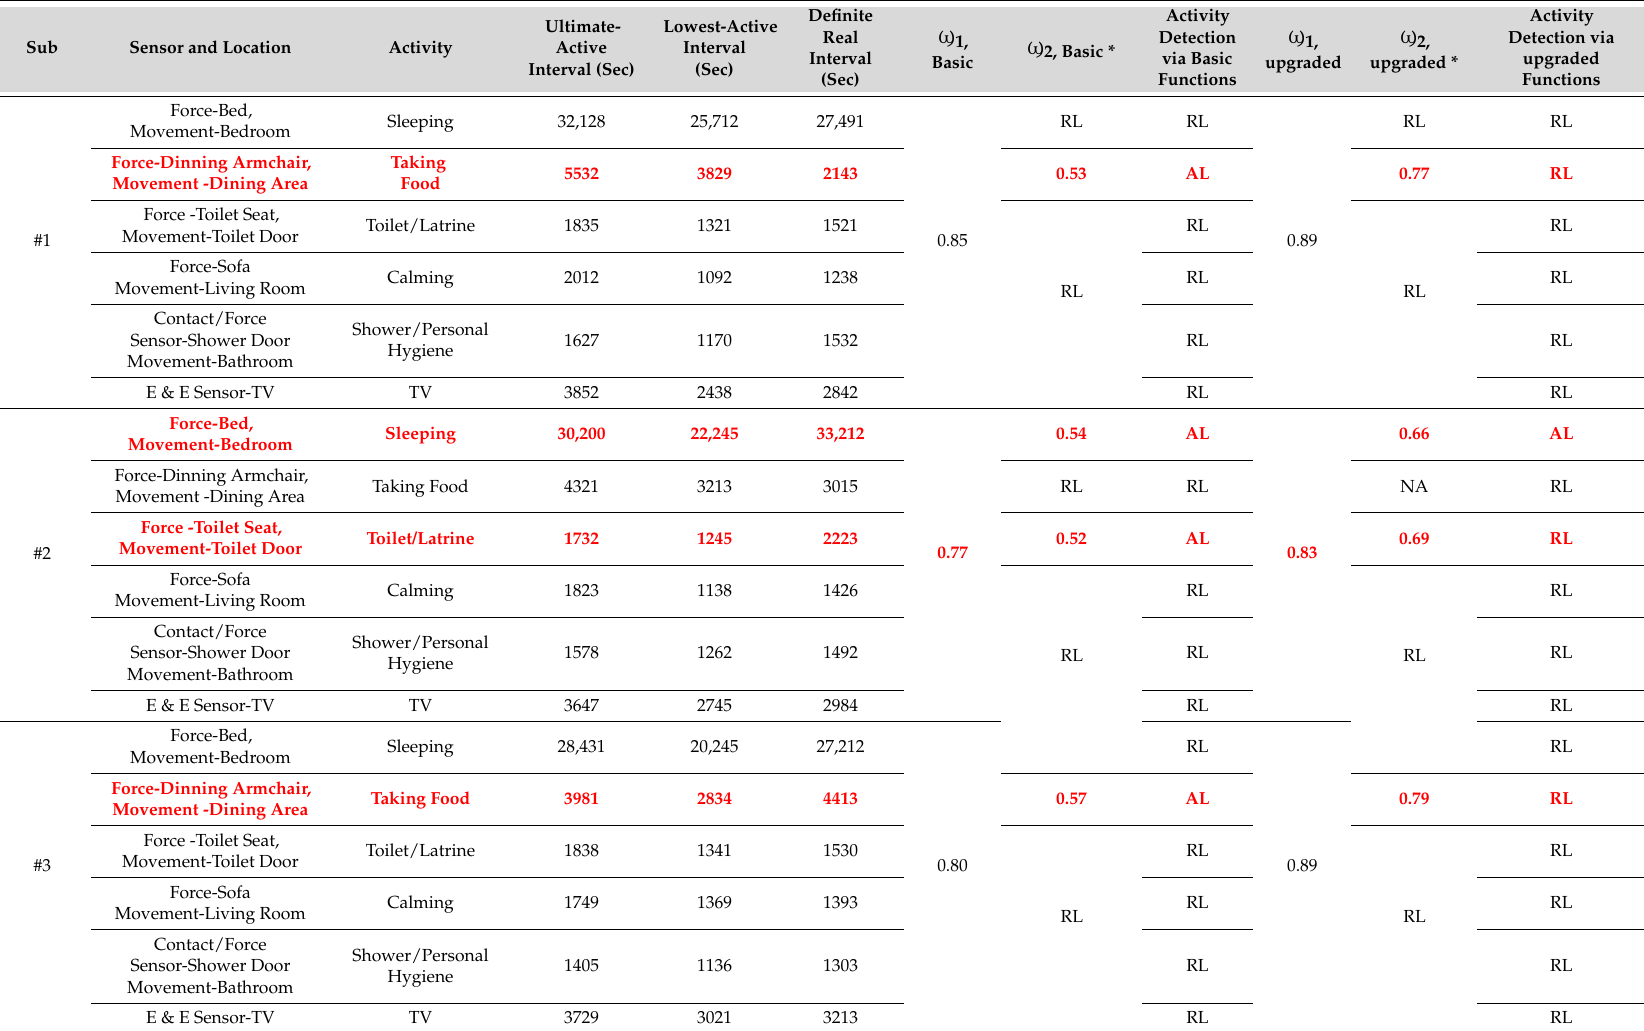
Table 3. Upgraded Wellness Function vs. Basic Wellness Function for recognizing